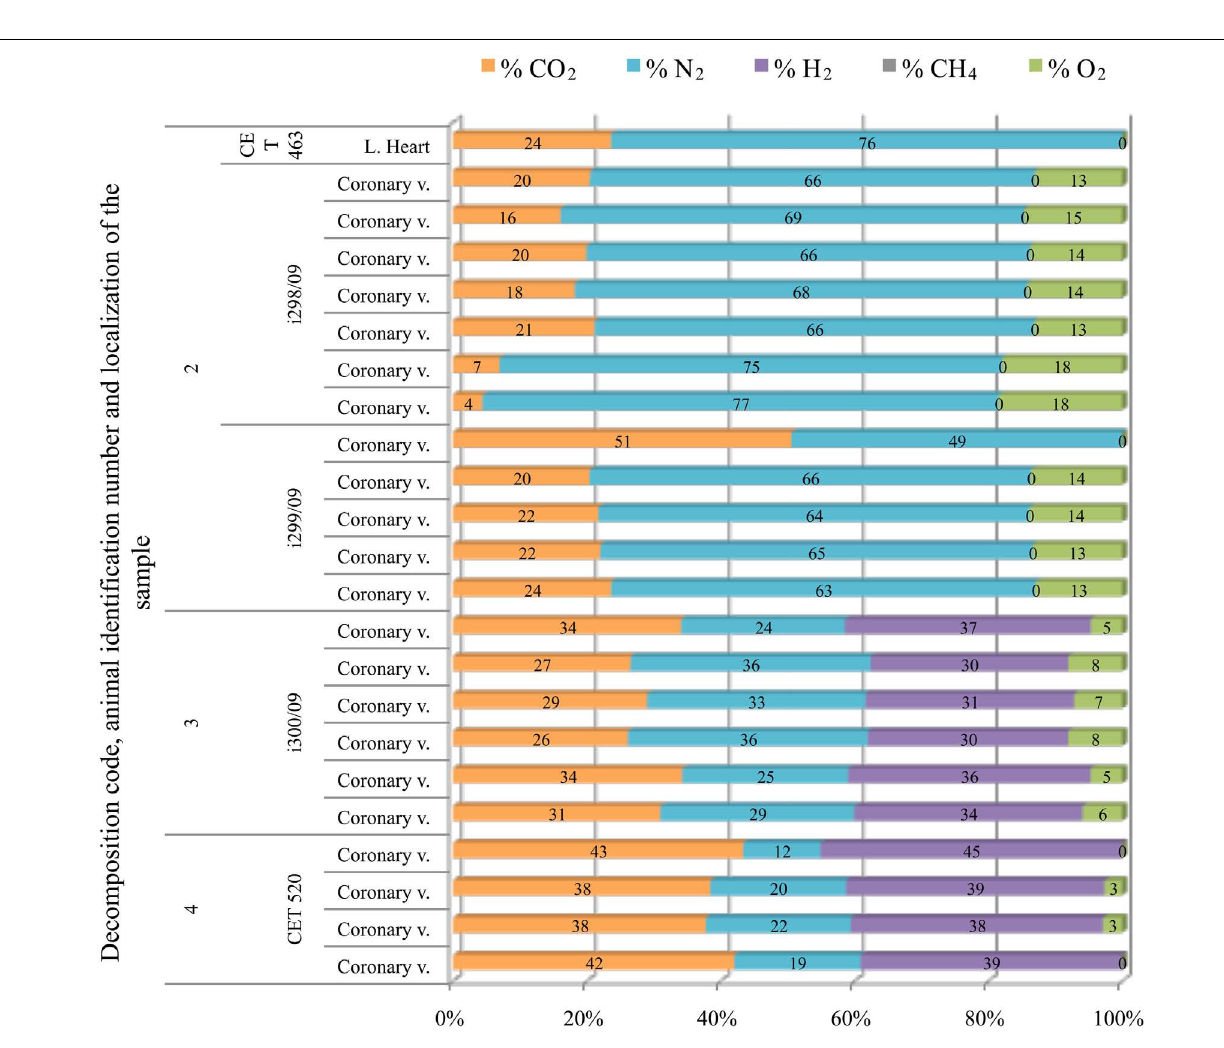
decomposition code 4, CO 2 increased devaluating nitrogen